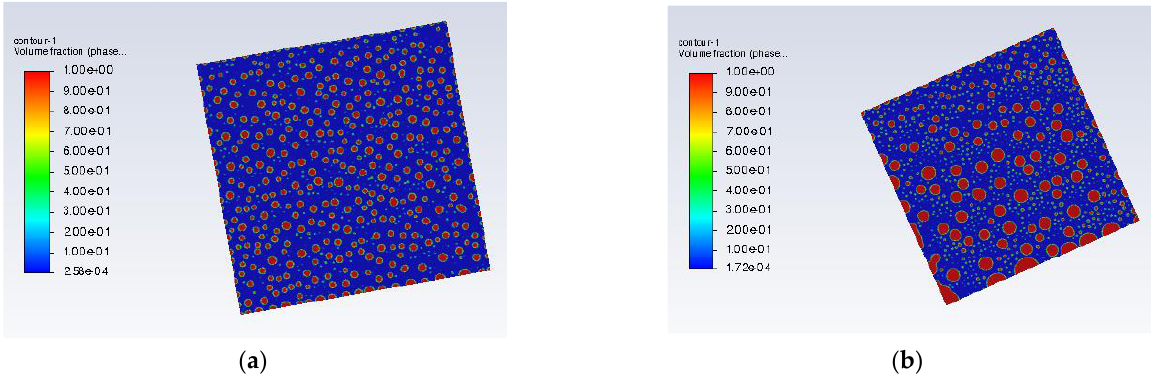
Figure 12. Droplet movement and distribution against time at a rotational angular velocity of 3.14 rad·s −1 and contact angle of 90°: ( a ) 0.2 s; ( b ) 0.3 s. Table 6. Comparison of the equivalent evaporation rates in dropwise condensation at different rotational angular